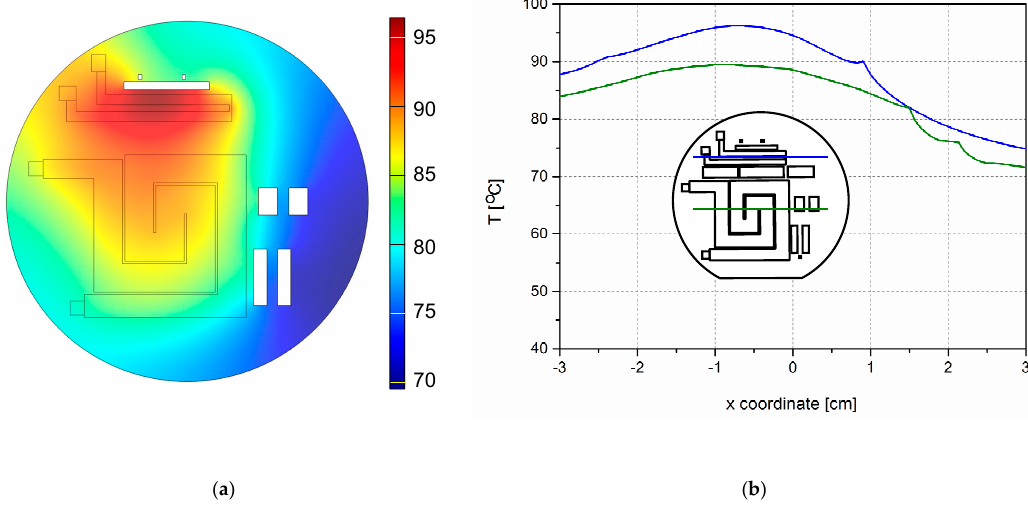
Figure 4. Simulation of temperature distribution in and around the monolithically integrated p-type heaters in the microreactor without thermal isolation between the heaters for the current values I H2 = 80 mA and I H1 = 120 mA after 20 min; ( a ) spatial distribution of temperature; ( b ) temperature gradient across the centers of both heaters. The inset shows both heaters on the wafer, as well as the thermal isolation apertures (centers are marked by horizontal lines). Green lines denote the larger heater H1, while blue lines correspond to the smaller heater H2.